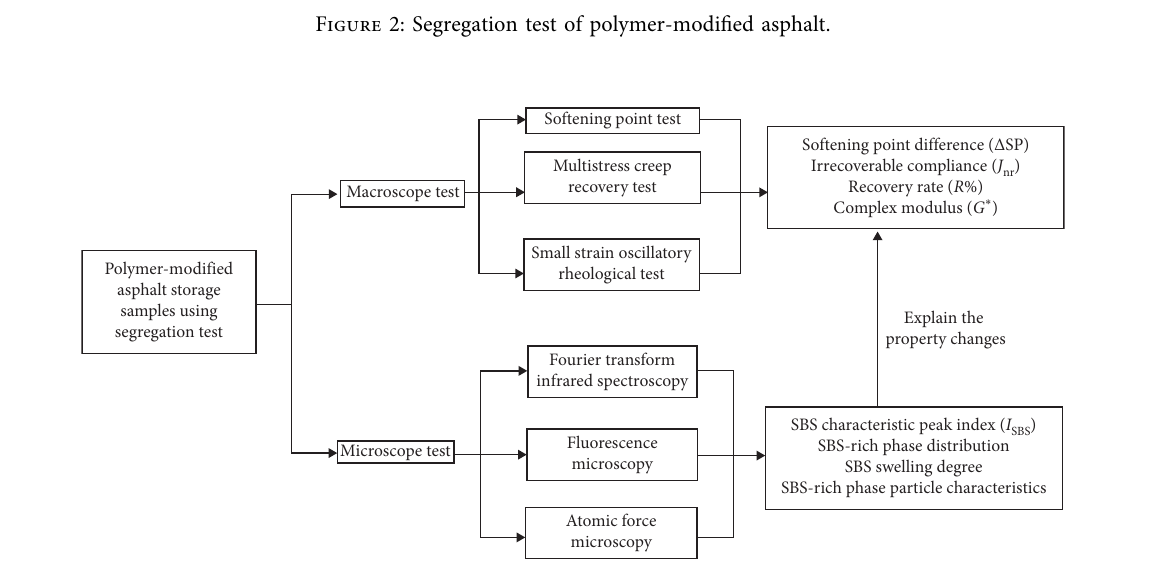
Figure 3: Experimental design